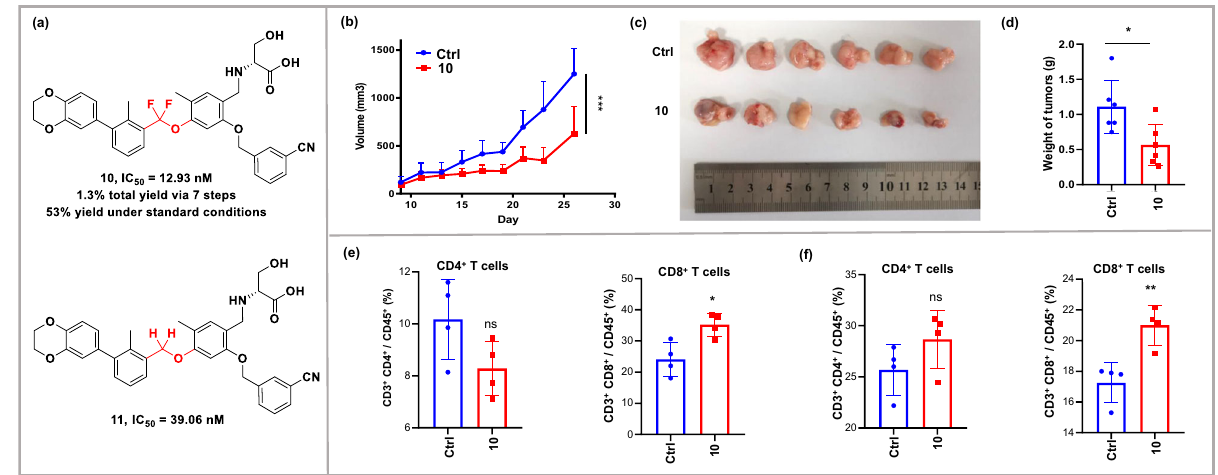
Fig. 5 Treatment with compound 10 inhibited tumor growth in vivo and remodeled facilitated the in fi ltration of CD8 + T cells. a PD-1/PD-L1 immune checkpoint inhibitor activity of di fl uorinated compound 10 and non- fl uoro compound 11 . b The growth of transplanted MC38 tumors after local injection of 20 mg/kg compound 10 or vehicle daily. Data are presented as mean ± SEM ( n = 8, *** P < 0.001, two-way ANOVA). c Image of excised tumors from. d weight of excised tumors from. e Representative plots (left) and frequency (right) of CD4 + T cells and CD8 + T cells in tumors. f Representative plots (left) and frequency (right) of CD4 + T cells and CD8 + T cells in spleens, data are presented as mean ± SD ( n = 4, ns P > 0.05, * P < 0.05, ** P < 0.01, t